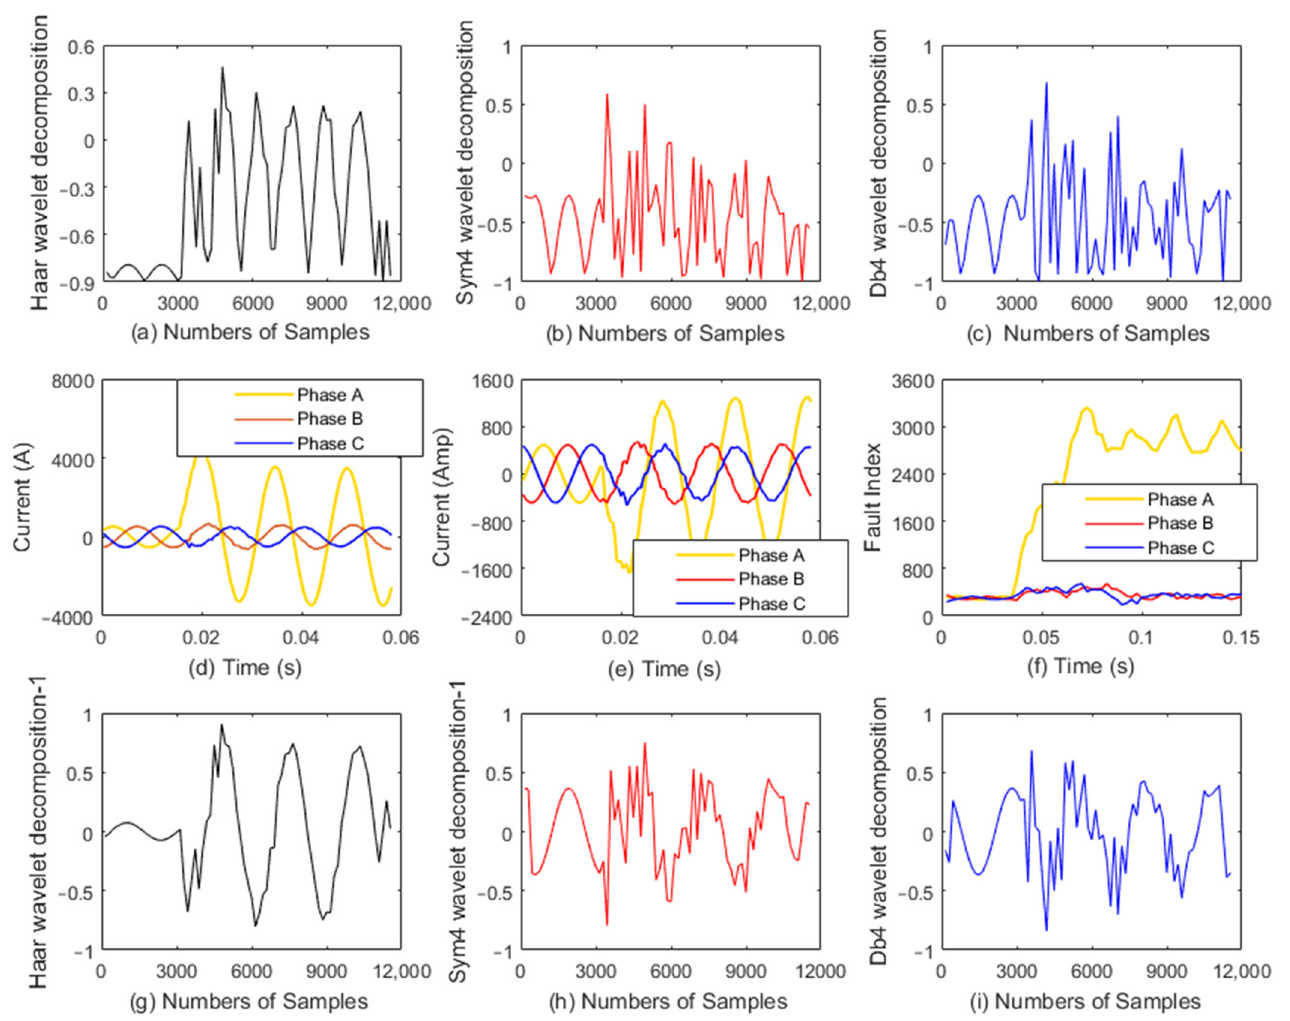
Figure 8. ( a – c ) Different wavelet detections at one end of the cable; ( d – f ) current effects; ( g – i ) different wavelet detections at the second end of the cable.